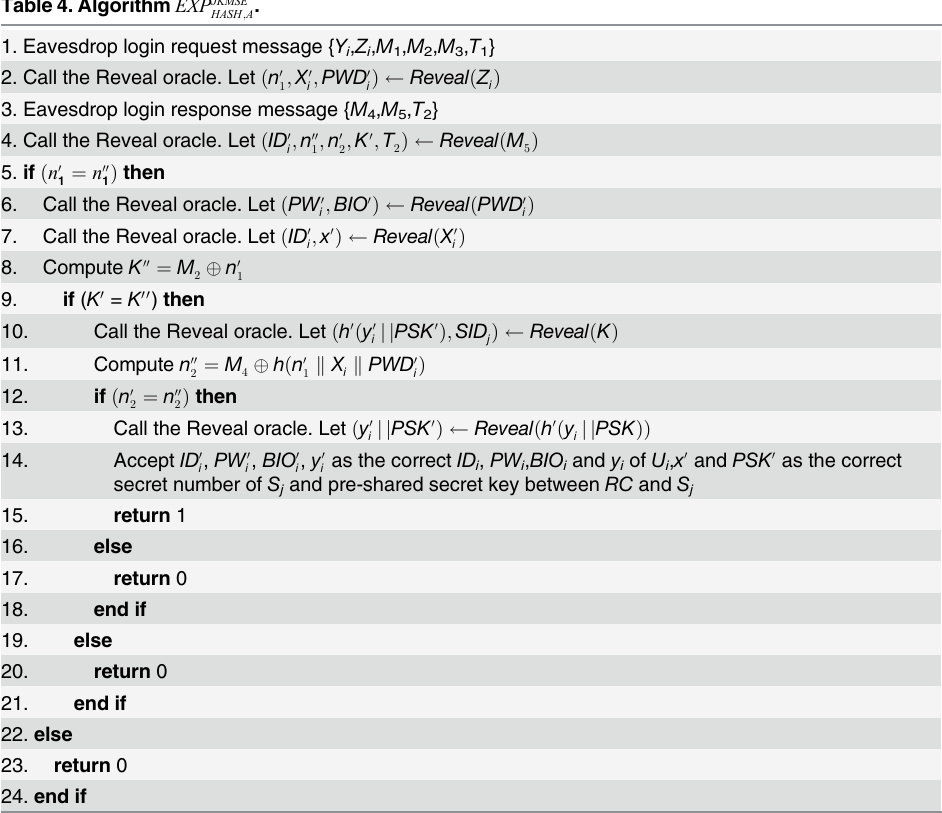
Table 4. Algorithm EXP JKMSE HASH ; A